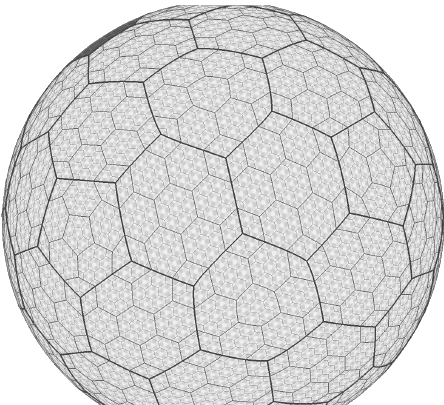
Figure 2. Snyder Equal Area projection performed on a regular hexagon grid [11]. While the areas of the projected hexagons are preserved, the shapes and angles are not. Image modified from [12], licensed under Creative Commons BY-SA